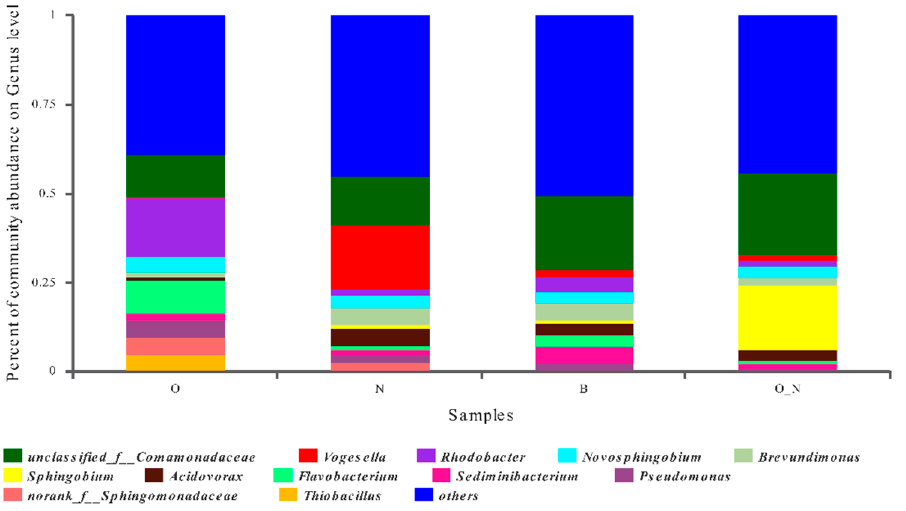
Figure 7. Comparison of bacteria groups on genus level (abundance > 5%) of groups B, N, O, and O_N.